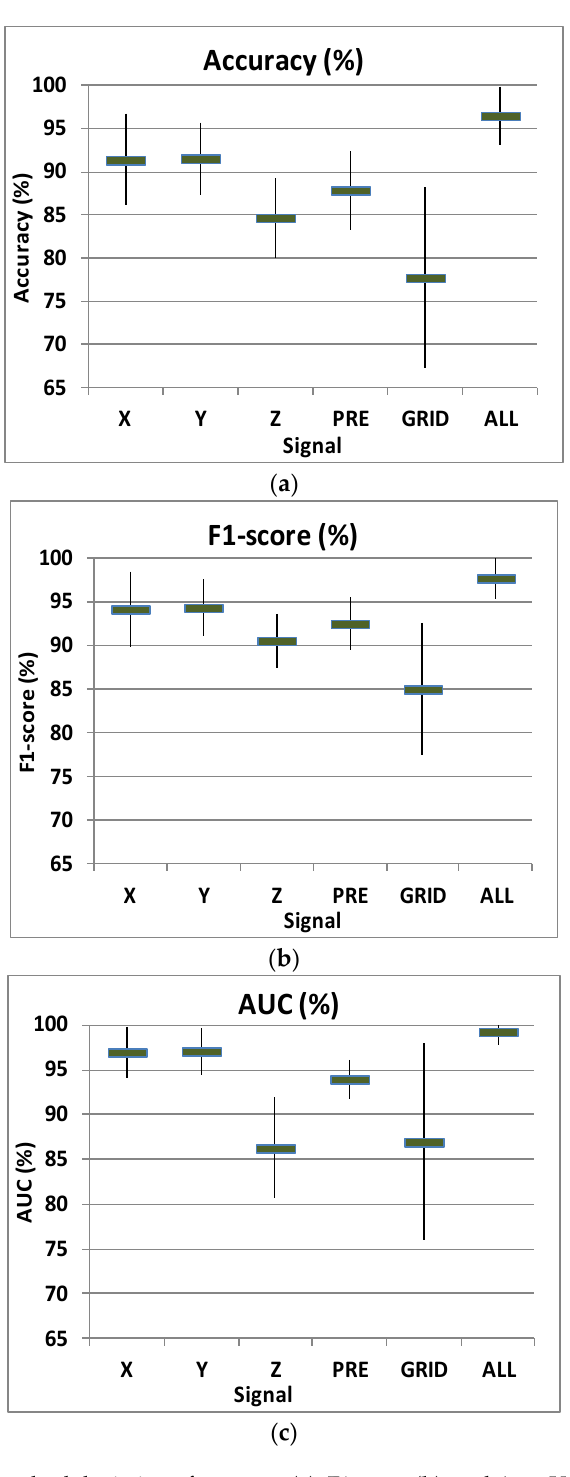
Figure 4. Mean and standard deviation of accuracy ( a ), F1-score ( b ), and Area Under the Curve (AUC) (%) ( c ) for every signal independently: X, Y, and Z coordinates, pressure (PRE), and grid angle (GRID) and including all the signals together (ALL).